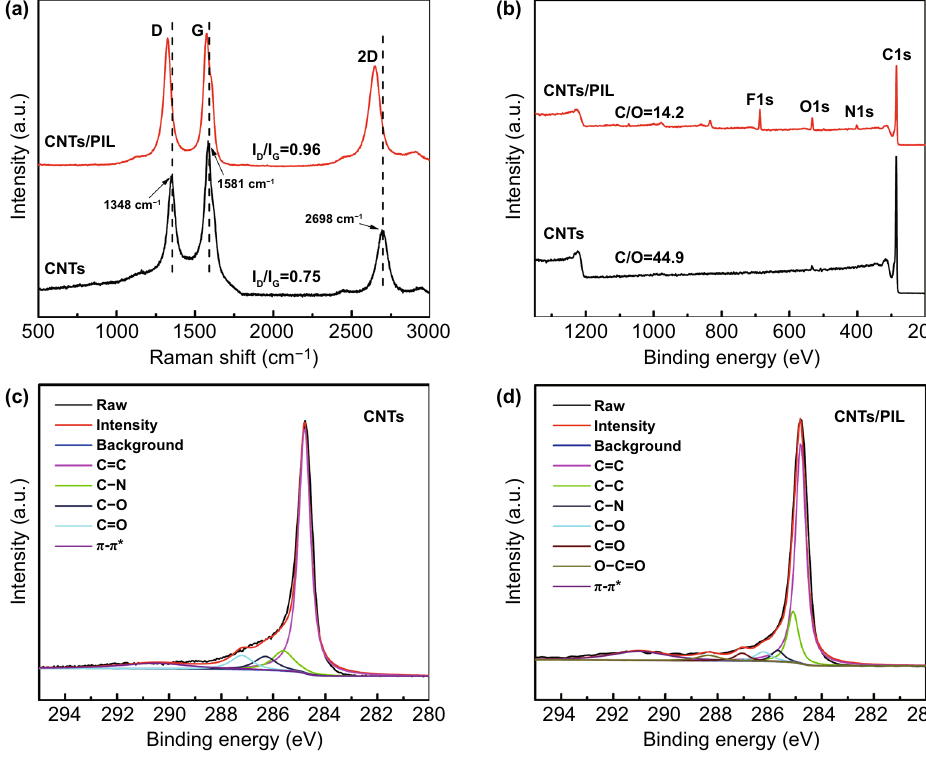
Fig. 1 Raman spectra a and XPS spectra b of CNTs and CNTs/PIL; C 1 s XPS spectra of CNTs c and d